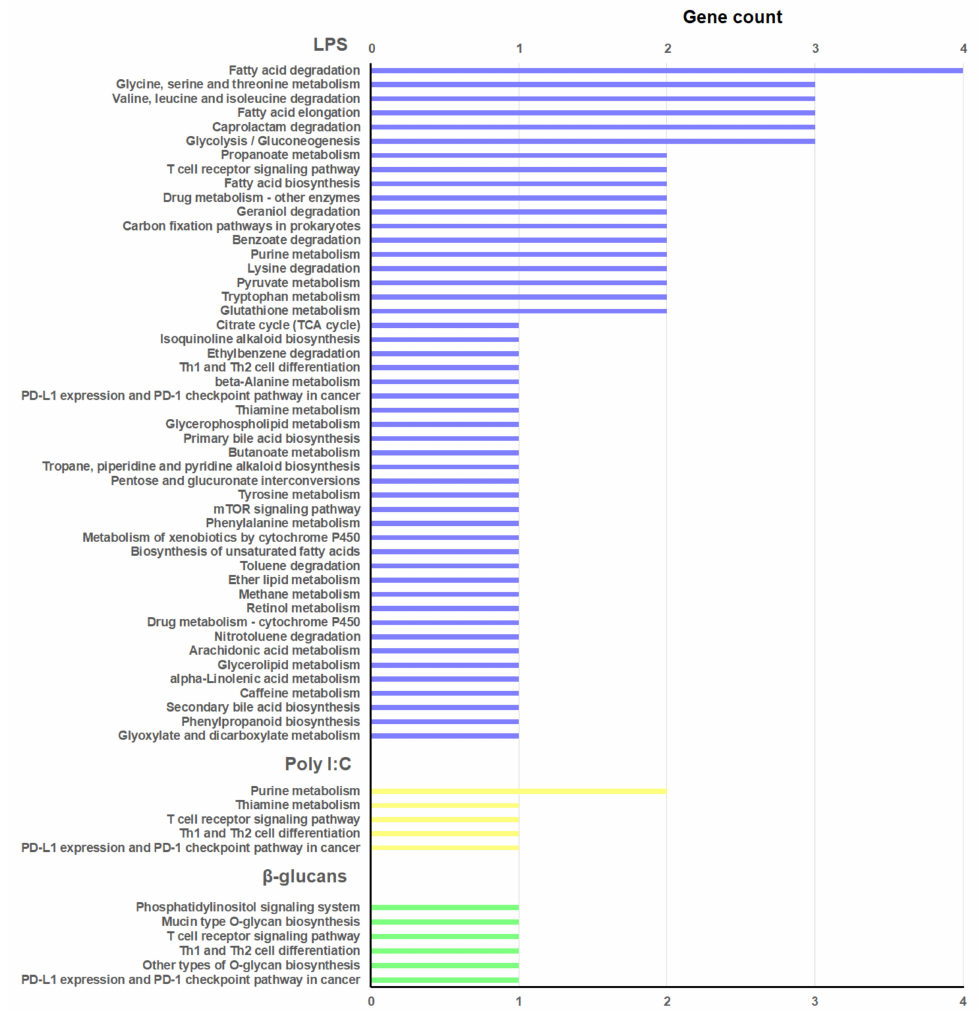
Figure 5. KEGG pathway analyses of the DE lncRNA-neighboring coding